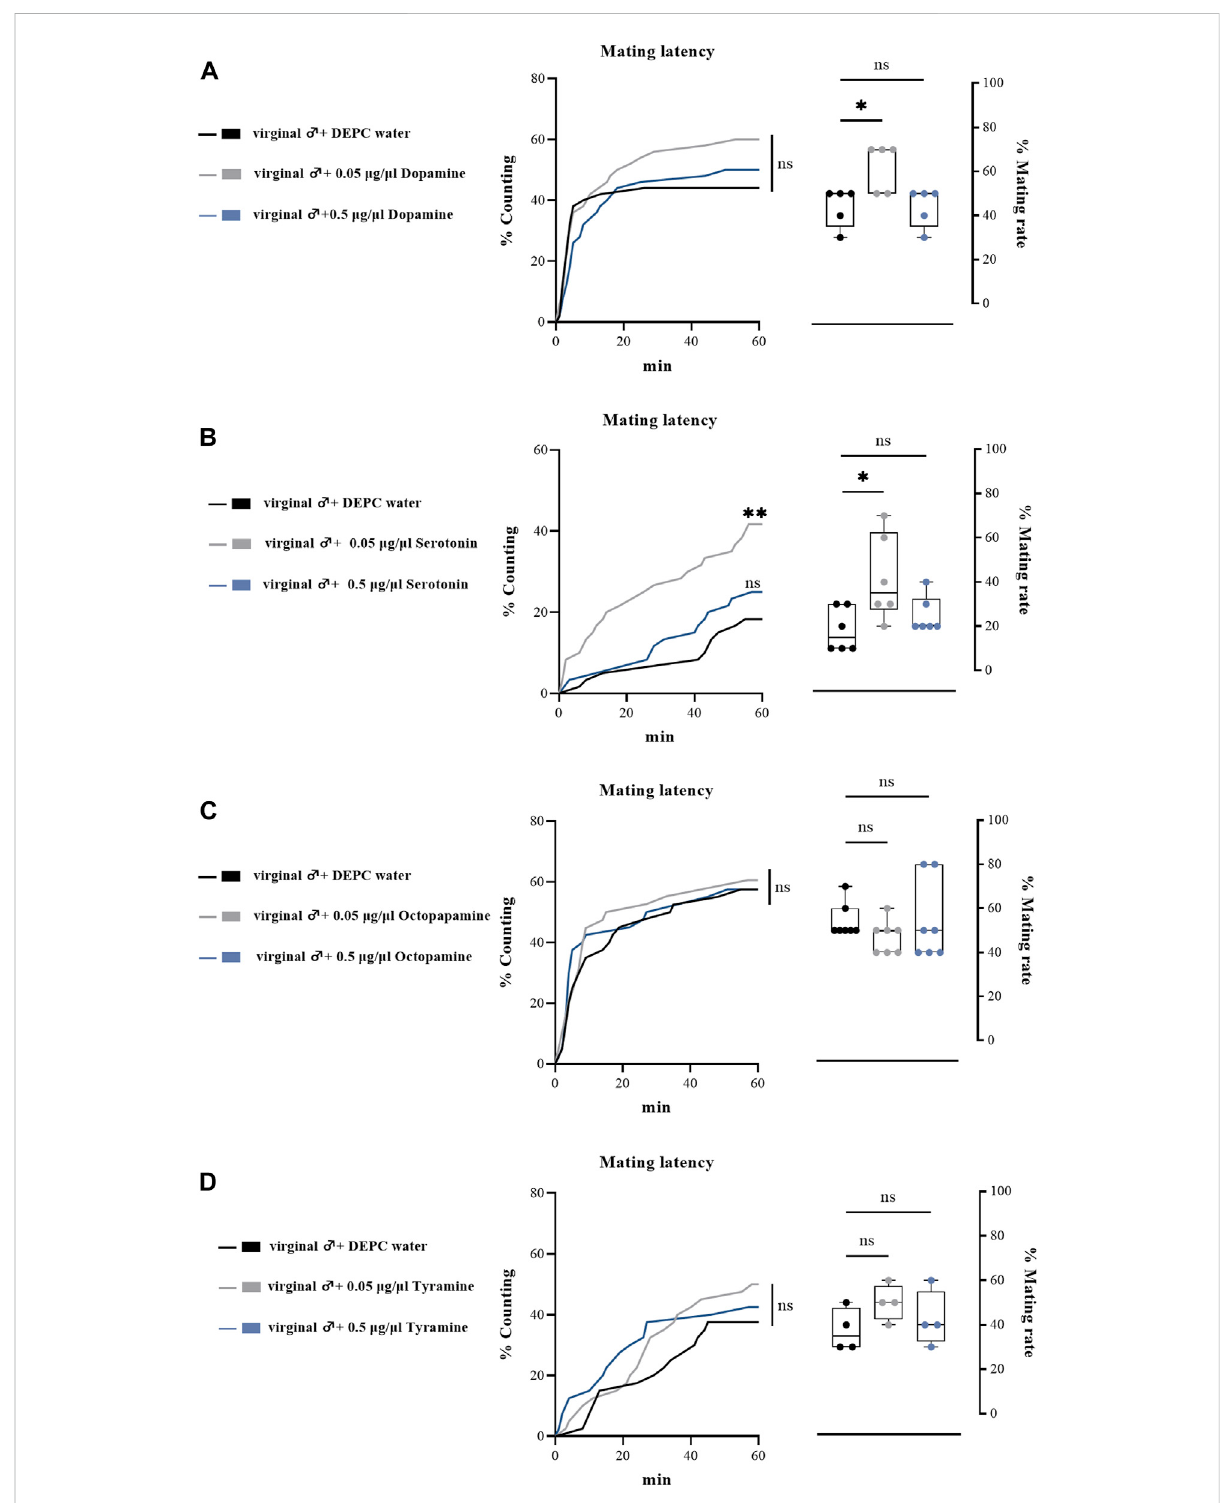
FIGURE 4 Changesinmating latencyandmating rates following pharmacologicaltreatments. Mating assayswereperformedat2 hafter biogenicamine- injection in virginal male fl ies (13th day post emergence). DEPC water treatment was served as control. For treatment groups, 0.05 μ g/ μ l dopamine (A) , serotonin (B) and octopapamine (C) and tyramine (D) were injected, respectively. Values are the means (± SEs) of replicates. Statistical comparisons were conducted by comparing each treatment with control, respectively, and based on Log-rank (Mantel-Cox) test (mating latency) and Students ’ s t test (mating rate). The level of signi fi cance for the results was set at * p < 0.05, ** p < 0.01, *** p <